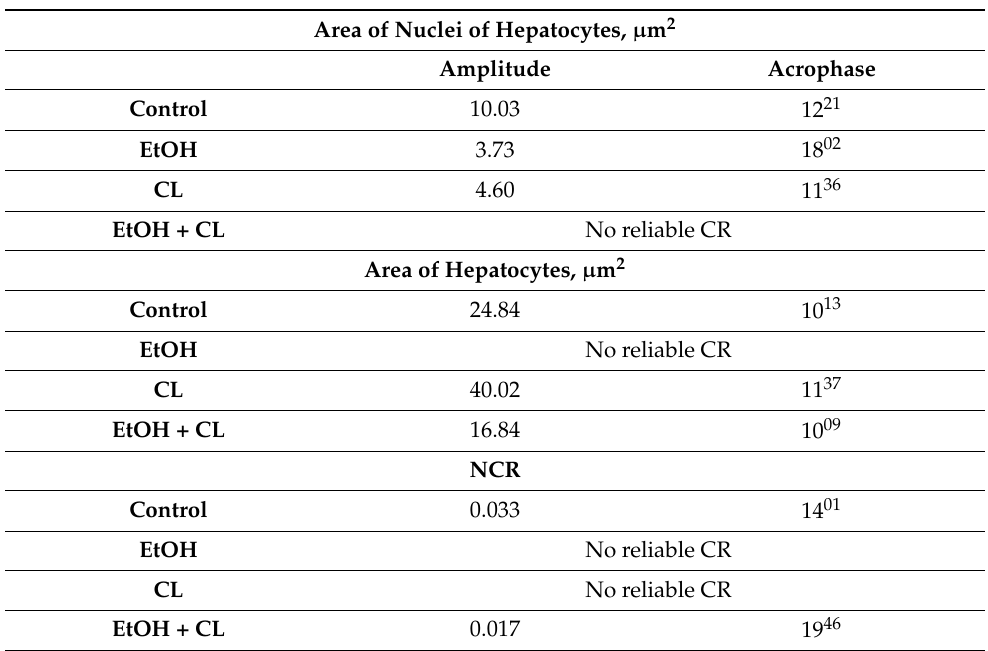
Table 2. Cosinor analysis of the micromorphometric parameters of rat livers.